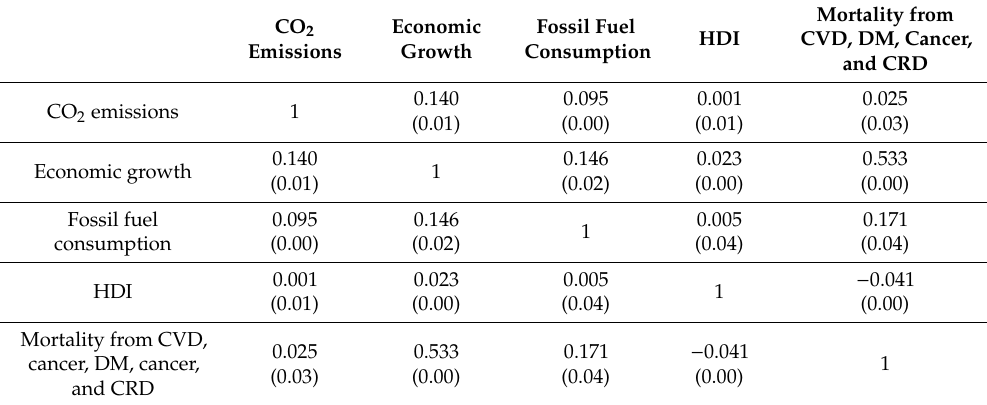
Table 1. Pearson correlation among the